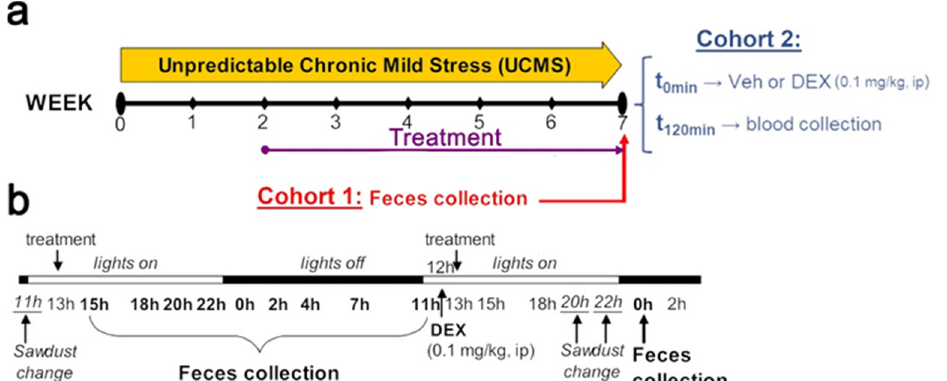
Figure 1. Schematic representation of the experimental design. ( a ) BALB/cByJ mice were exposed to either a 7-week unpredictable chronic mild stress (UCMS) procedure or control conditions. Treat- ment with either a CRF-R1 antagonist (crinecerfont, 20 mg · kg − 1 · day − 1 , ip) or vehicle (5% DMSO, 5% Cremophor) starting after two weeks of UCMS and for a total of 5 weeks at the time of either fecal sample collection (cohort 1) or blood collection (cohort 2). ( b ) Detailed time schedule of the fecal sample collection and the dexamethasone (DEX) administration in cohort 1. Nine time points over a day were used to assess baseline HPA axis circadian activity. For the dexamethasone suppression test, 12 h separated the DEX ‐ P injection and the fecal sample collection.